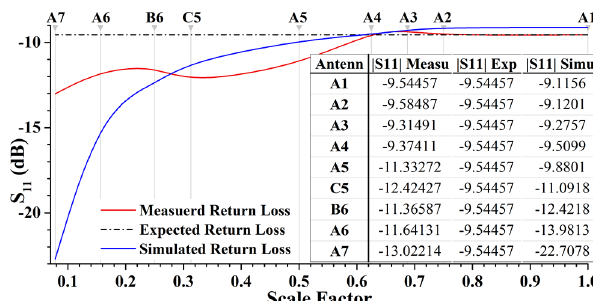
Figure. 6. The decaying measured and simulated magnitude of S 11 for various antennas (with soldered SMA connector) as function of scale-factor.